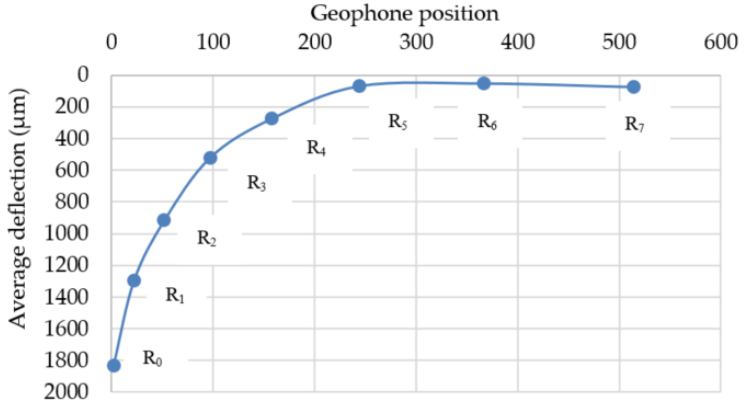
Figure 10. Example of FWD deflection basins’ layout.